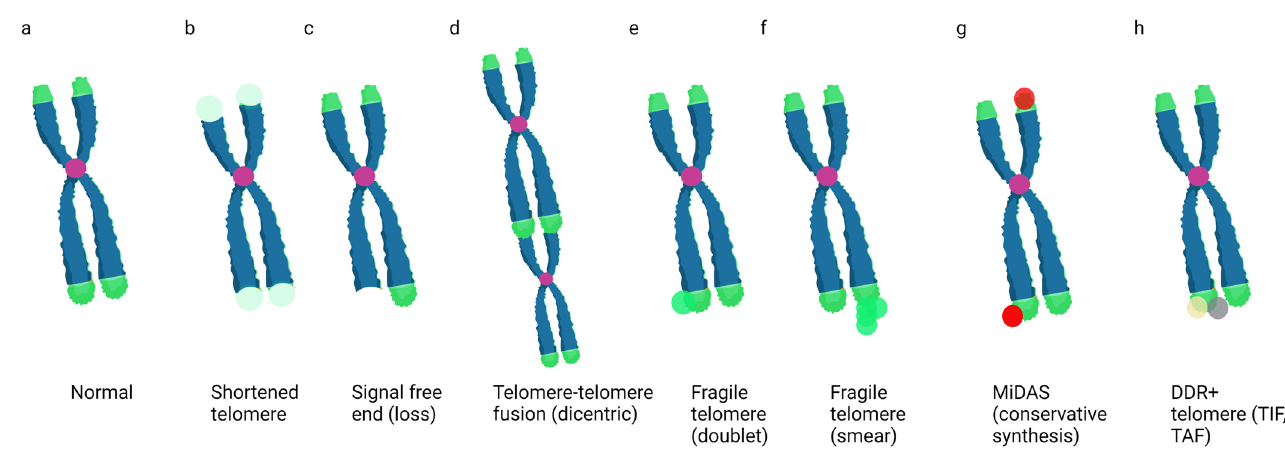
Figure 1. Examples of Telomere Aberrations Detected on Metaphase Spreads . Cartoons of a chromosome with normal telomere ends ( a ), shortened telomeres (light green) ( b ), a signal-free end or telomere loss ( c ), a telomere–telomere fusion or dicentric chromosome ( d ), fragile telomeres ( e , f ), mitotic DNA synthesis ( g ), and a telomere containing DNA-damage-response proteins such as γ H2AX or 53BP1 ( h ). Green = telomeres; purple = centromeres; red = EdU foci; yellow and gray = DDR proteins. Created in BioRender.